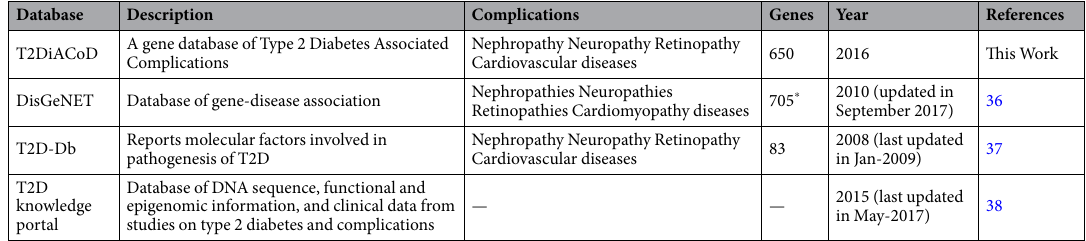
Table 2. Comparative statistics of available resources for T2DM complications. * Genes are either associated in Type 1 Diabetes or are false matches (included genes without strong evidences and with negative evidence i.e. co-occurrence of disease and gene in a statement). DisGeNET has collected data from different sources i.e. UniProt, ClinVar, Orphanet, The GWAS catalog, CTD, RGD, MGD and literature data from GAD, LHGDN and